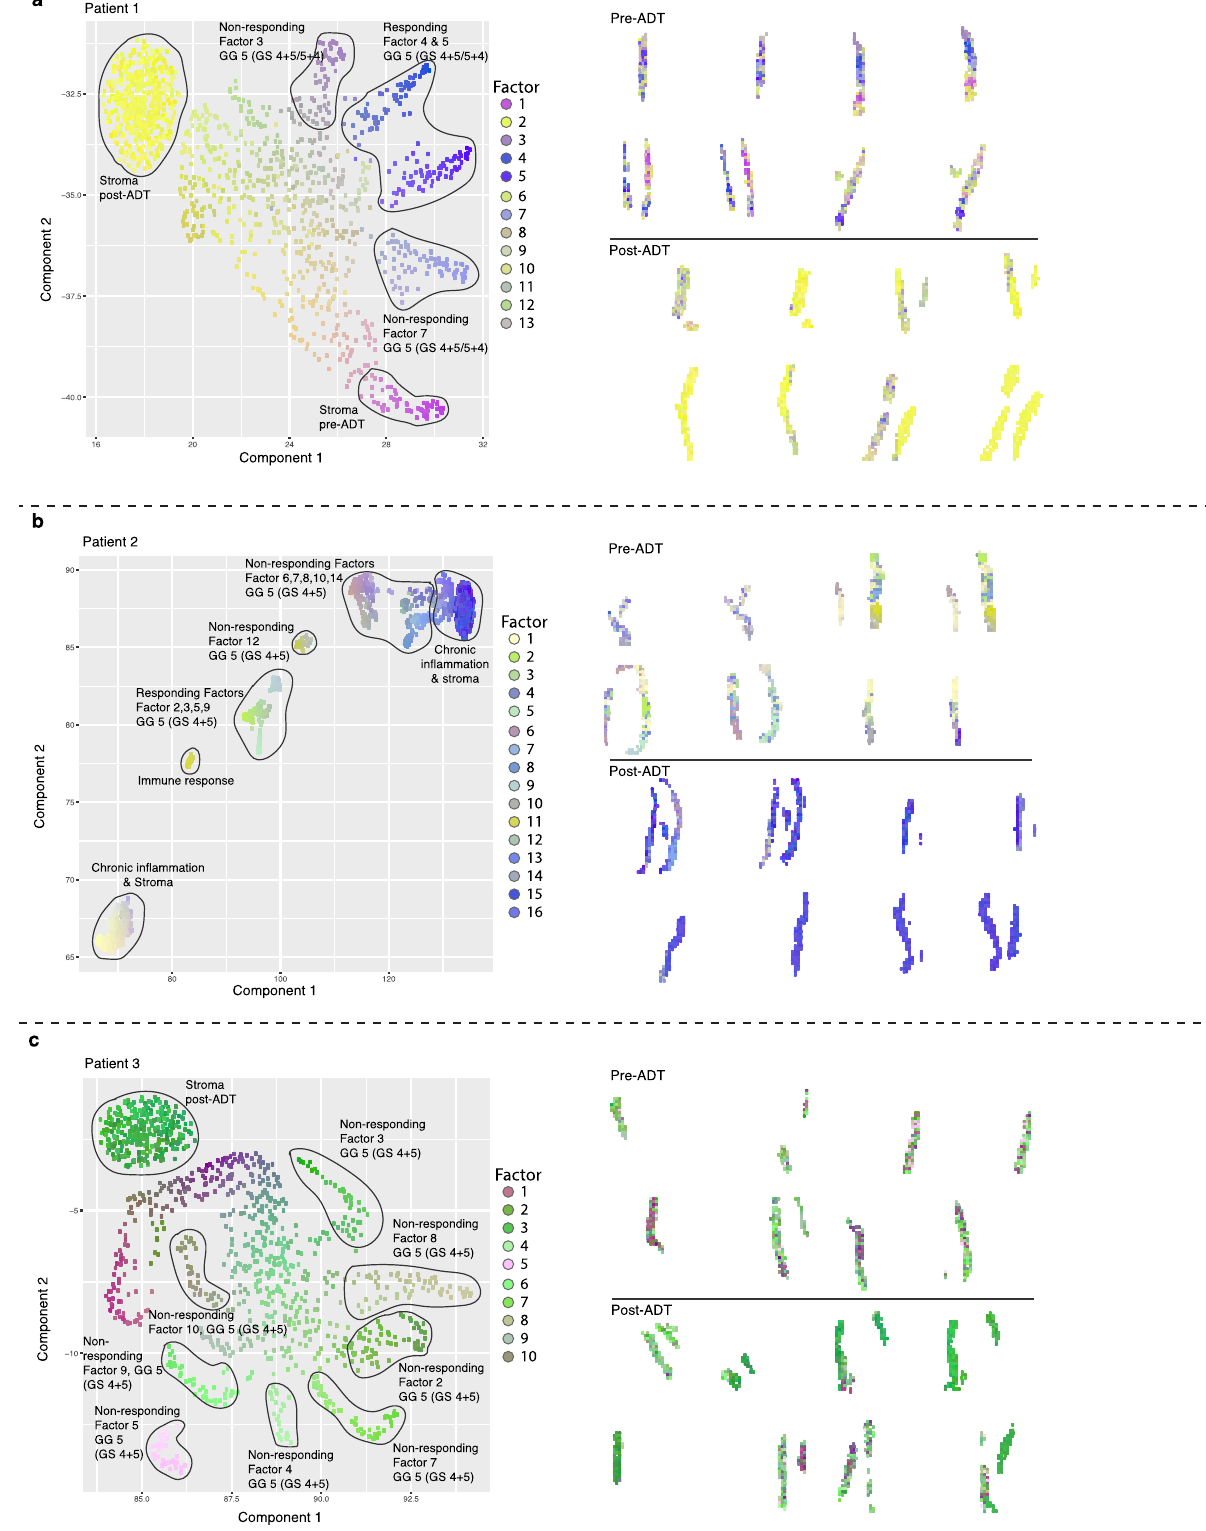
from factors of the same type are encircled. UMAP Uniform Manifold Approx- imation and